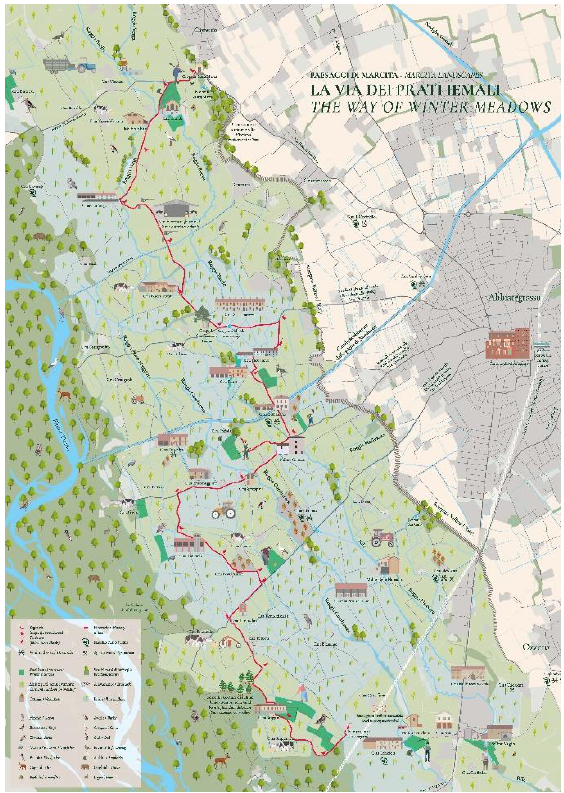
Figure 5. Winter meadows map ( recto